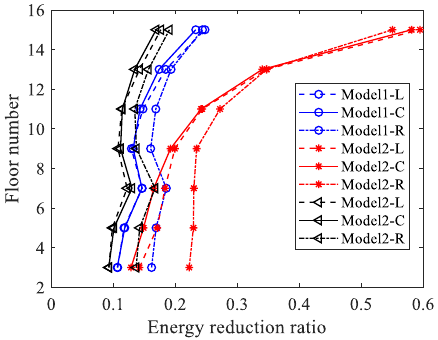
Figure 13. Energy reduction